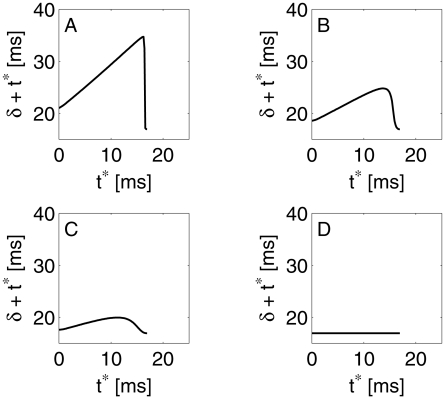
Same as
Fig. 5
, plotting  instead of .